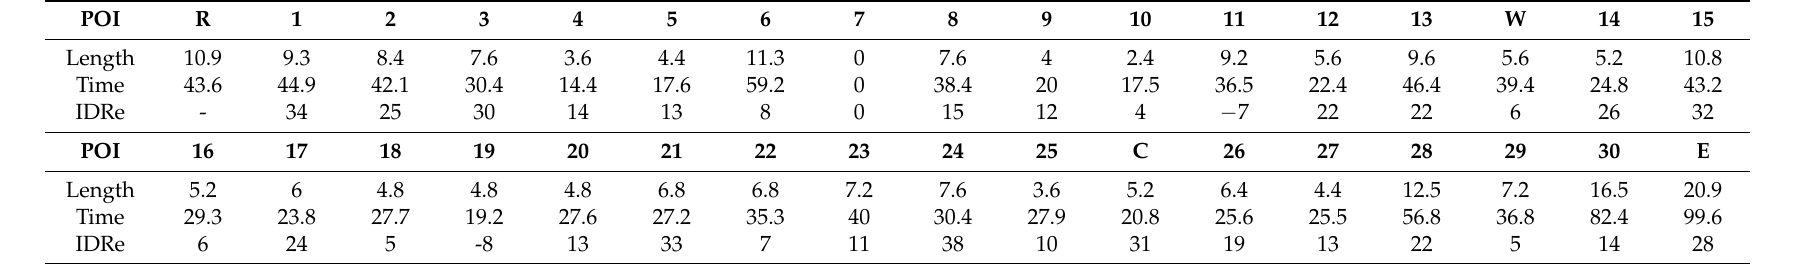
Table 1. Blind MuseumTourer indoor navigation system blindfolded trial